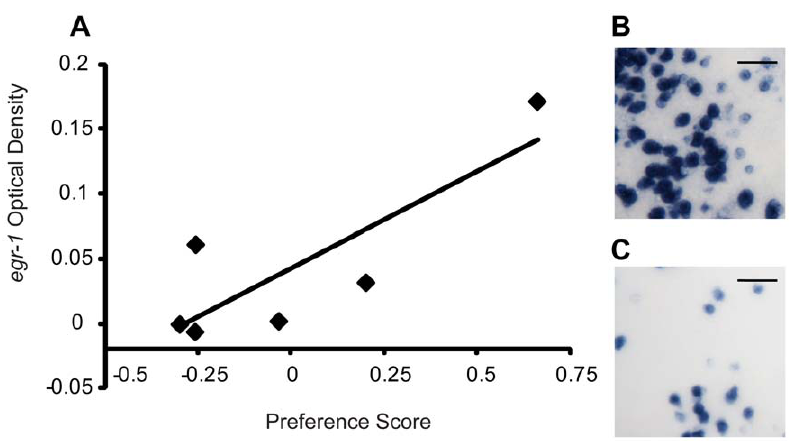
Figure 4. Individual variation of preference score and egr-1 expression. (a) Significant correlation between individual variation in preference score and egr-1 expression in Dm. Representative images of egr-1 expression in Dm for two individuals with a preference score of (B) 0.66 and (C) 2 0.26. Scale bar is 25 microns. LS (t= 3.23, p= 0.0026) and SS (t= 3.52, p =0.0028) male